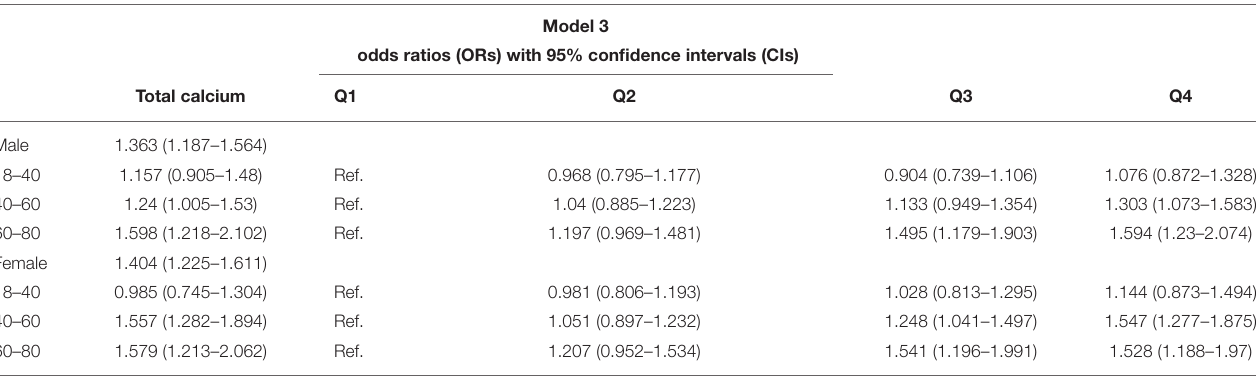
TABLE 3 | Association of calcium with hypertension by sex and age using fully adjusted